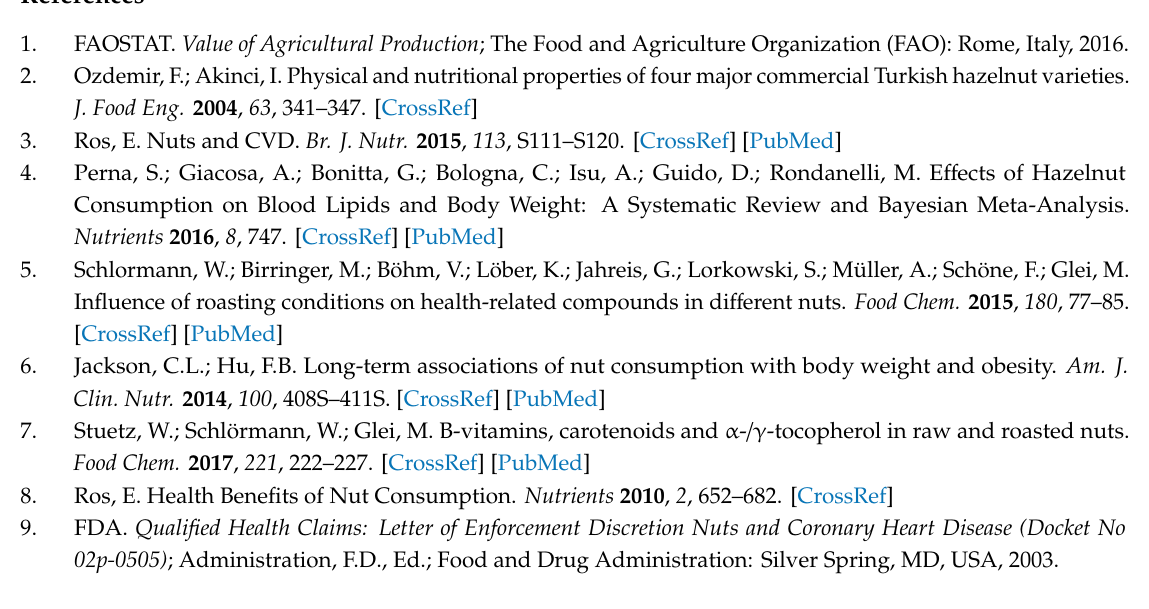
Table S1: Agronomic data of and observations for the 15 varieties cultivated in